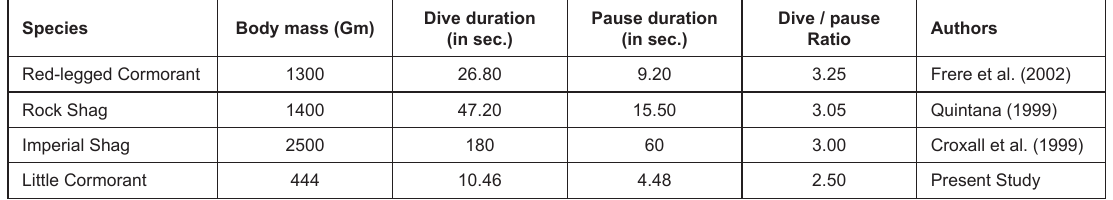
Table 2. Mean diving parameters and body mass of cormorants in literature and present